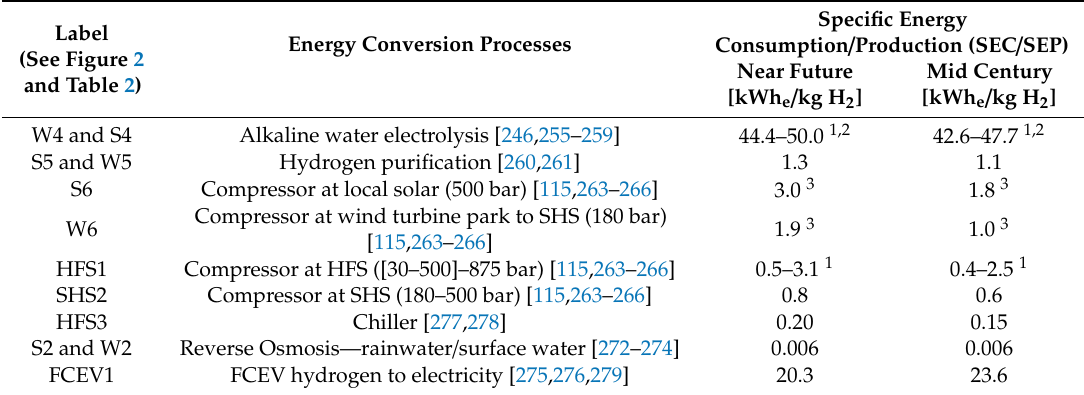
Table A2. Specific energy consumption SEC or production SEP (kWh e / kg H2) of the energy conversion processes in the smart city area for both scenarios and